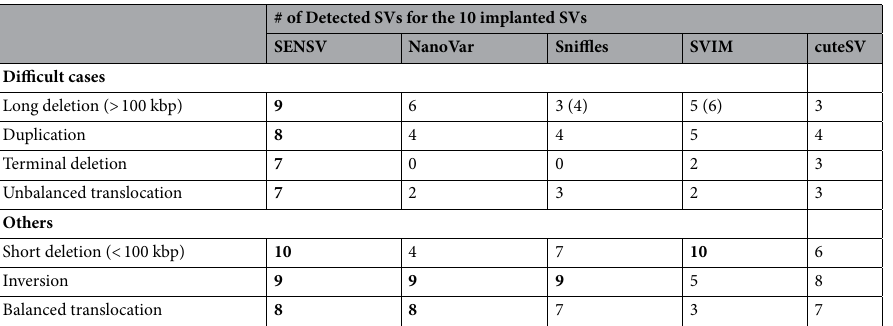
Table 3. The number of SVs detected with a breakpoint precision of 100 bp by the software grouped by SV types in two simulated datasets. The number in the parentheses is the number of SVs detected with a breakpoint precision of 2000 bp. Each type has total 10 SVs implanted in two simulated datasets. The best results of a row are in